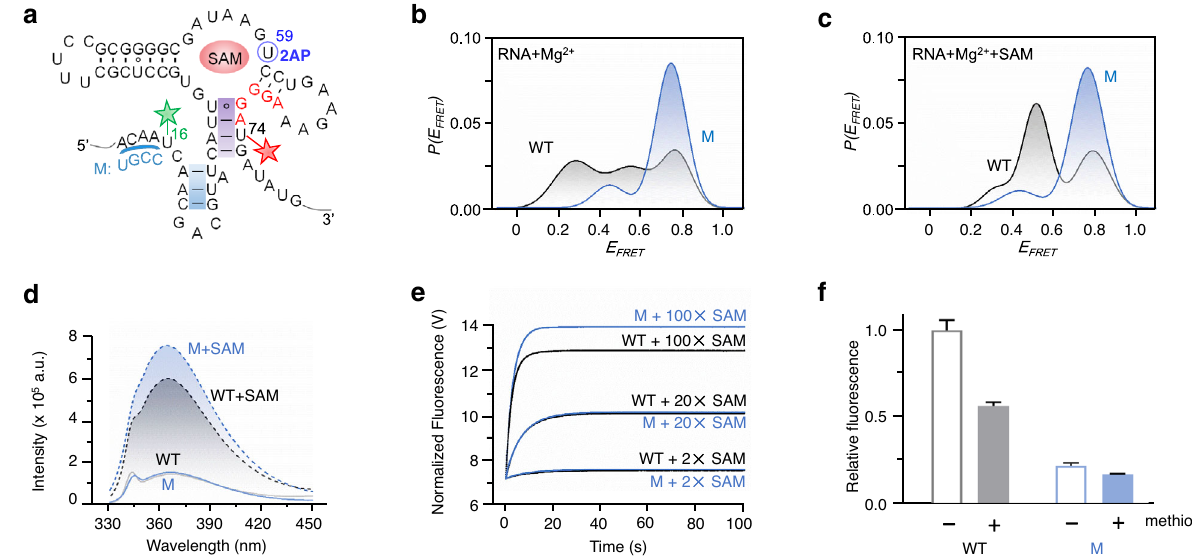
Fig. 7 | Functional characterization of transit in riboSAM. a The secondary structureoftheWTandthemutantofriboSAM,andthemutatednucleotidesarein blue. The FRET pair labeledatsites 16 and 74 in 16Cy3-74Cy5-riboSAM isshownby green and red stars. The RBS isshown in red. b , c Superposition of smFRET forthe WT(inblack)andthemutant(inblue)of16Cy3-74Cy5-riboSAMat2mMMg 2+ inthe presence of 0 ( b ) and 0.5mM SAM ( c ). d The steady-state fl uorescence spectra of the WT(inblack)and the mutant of riboSAM (in blue)at2mMMg 2+ inthe absence of SAM (solid lines) and in the presence of 0.1mM SAM (dotted lines). e The